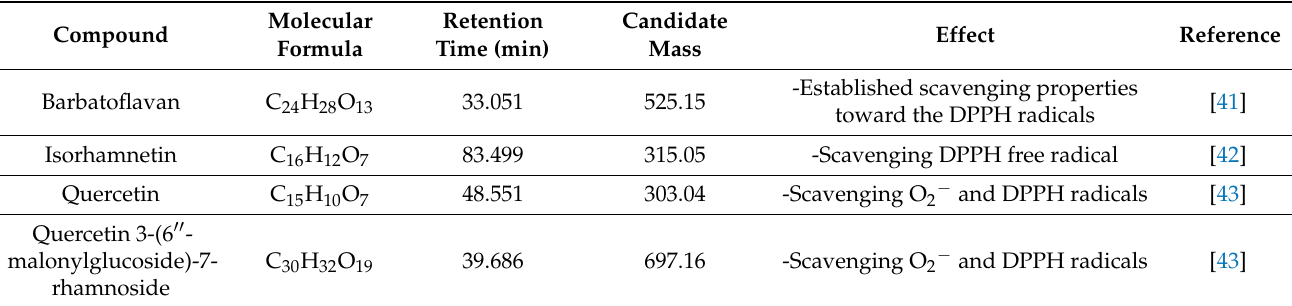
Figure 3. Liquid chromatography coupled with quadrupole time-of-flight mass spectrometry (LC–QTOF/MS) chro- matogram of MLE. Table 2. List of compounds identified in MLE by LC–QTOF/MS